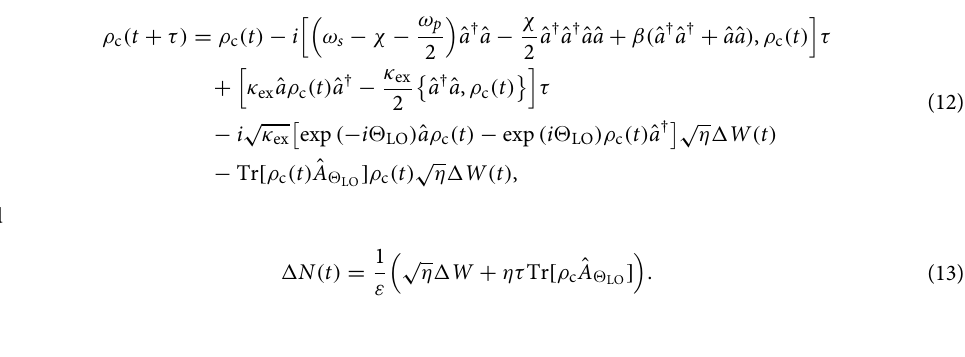
α in Eq. (2). The solid and dashed lines are for T U K and T L K , | | 0.95 and 0.99, respectively, where β was changed, while K is = α . ( b ) The same things as ( a ) but as a function of κ . The other parameters are the same | |